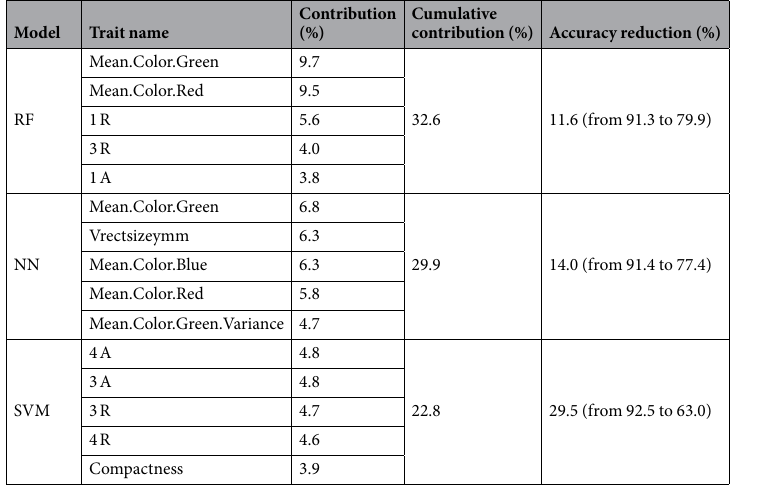
Table 4. The top five most contributing traits of each developed